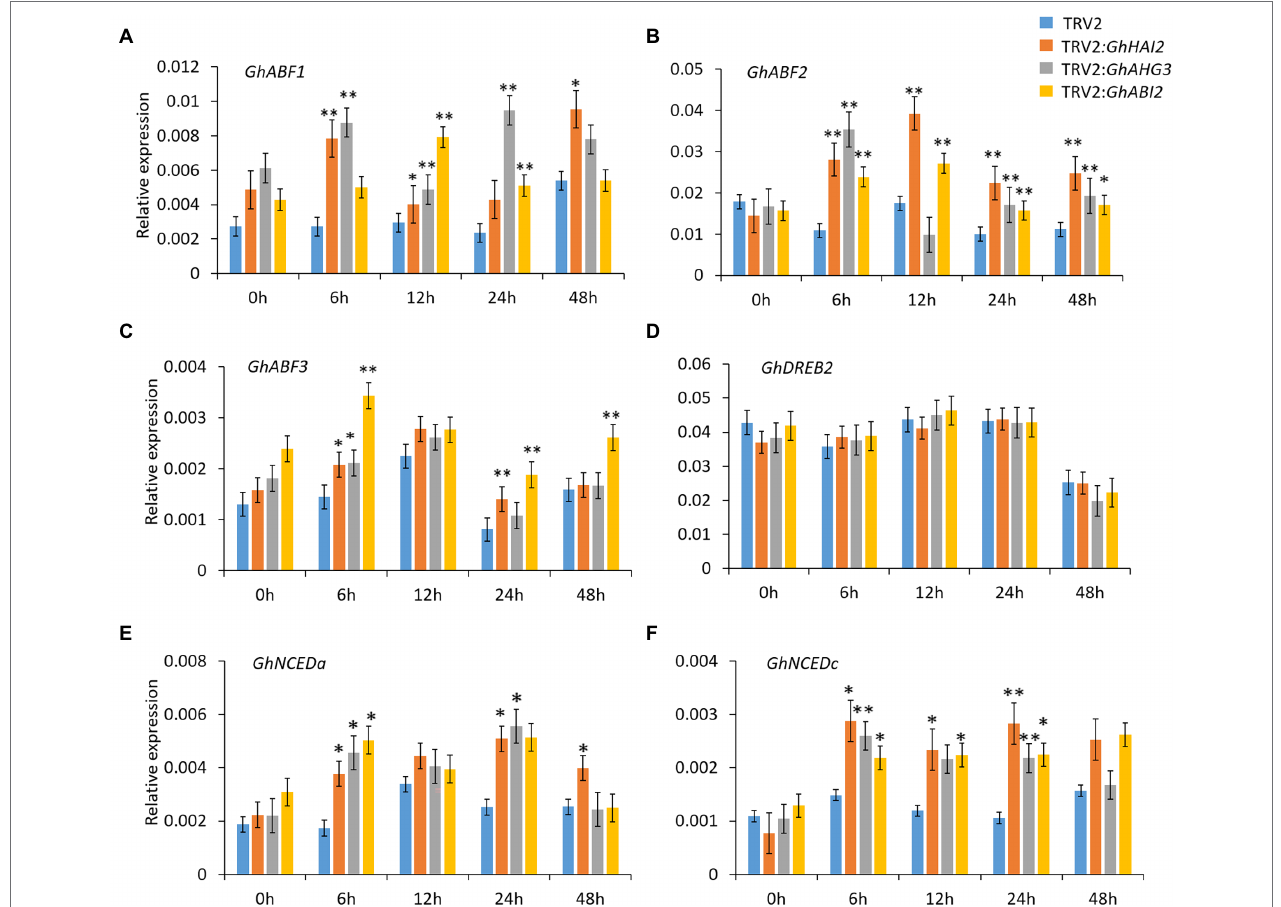
FIGURE 6 | GhHAI2 , GhAHG3, and GhABI2 regulate ABA-dependent gene expression. (A–C) qPCR expression analysis of ABA-dependent and (D) ABA- independent stress-responsive genes in TRV2: GhHAI2 , TRV2: GhAHG3, and TRV2: GhABI2 and TRV2:00 plants under PEG conditions. (E,F) Expression levels of ABA biosynthesis genes in TRV2: GhHAI2 , TRV2: GhAHG3, and TRV2: GhABI2 and TRV2:00 plants under PEG conditions. The transcript levels were normalized by GhHistone . Bars represent means ± standard deviation of three biological replicates. Asterisks represent statistically significant difference between TRV2: GhHAI2 , TRV2: GhAHG3, and TRV2: GhABI2 and TRV2:00 plants (Student’s t -test; * p < 0.05; ** p <